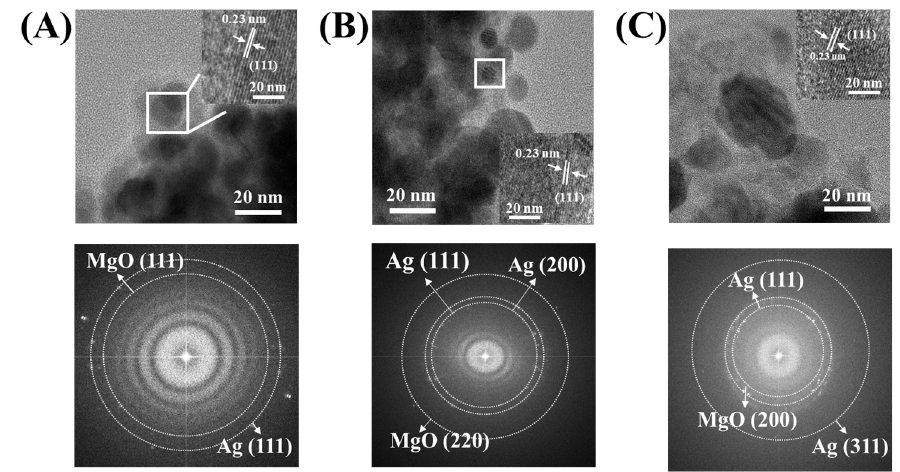
Figure 4. Magnified FE-TEM images and corresponding fast Fourier transform (FFT) patterns for ( A ) Ag@LDO400, ( B ) Ag@LDO500, and ( C ) Ag@LDO600.